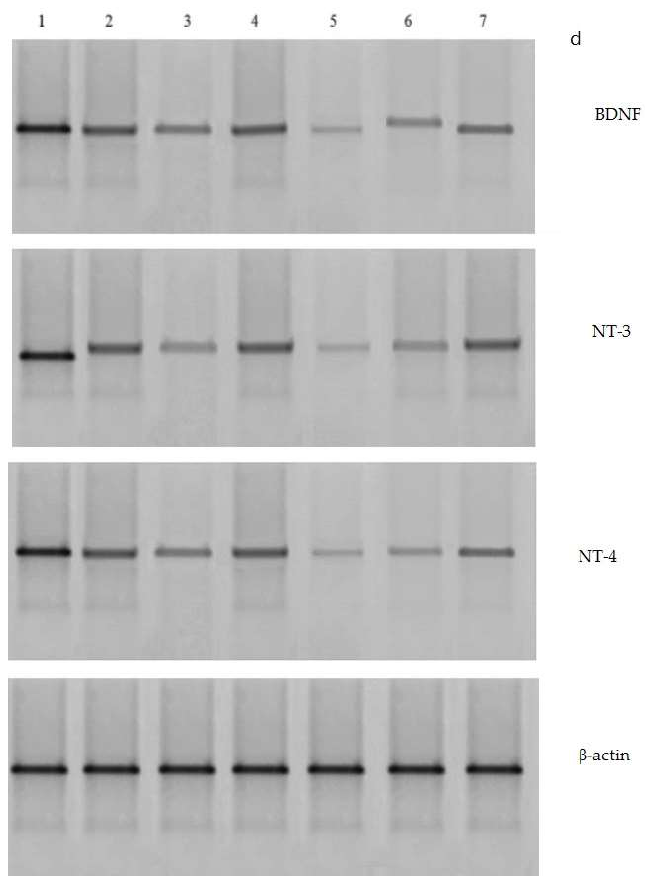
Figure 8. Effects of VD 3 administered in various doses on hippocampal BDNF (a) , NT-3 (b) , and NT- 4 (c) relative expressions in the long-term OVX rats subjected to CUMS. ( d )1—non-CUMS SHAM (control) rats, 2—SHAM rats with CUMS, 3—OVX rats with CUMS plus saline, 4—OVX rats with CUMS plus fluoxetine (10.0 mg/kg), 5—OVX rats with CUMS plus VD 3 (1.0 mg/kg), 6—OVX rats with CUMS plus VD 3 (2.5 mg/kg), 7—OVX rats with CUMS plus VD 3 (5.0 mg/kg). *— p < 0.05 versus the non-CUMS SHAM group (control group) treated with saline, #— p < 0.05 versus the SHAM